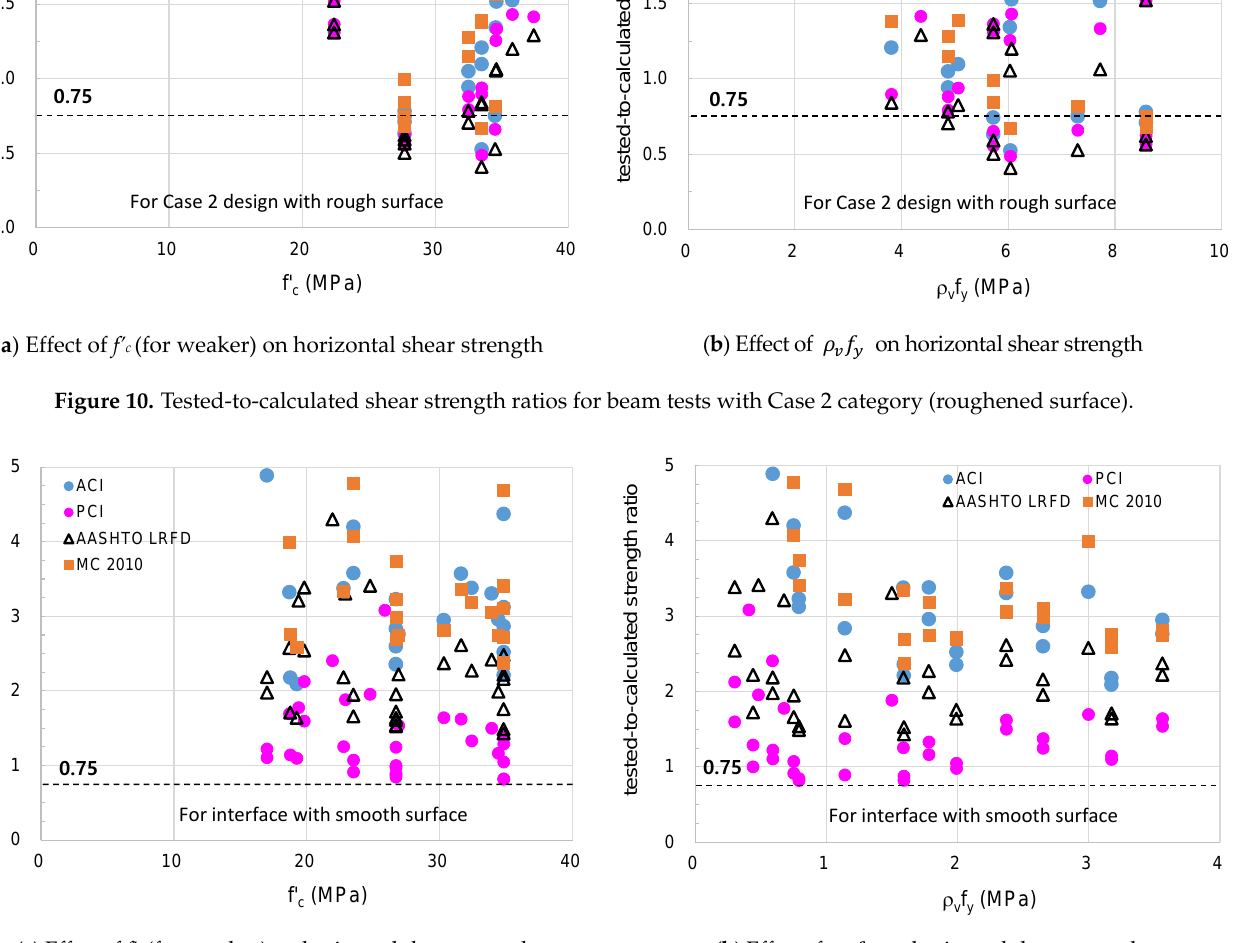
Figure 11. Tested-to-calculated shear strength ratios for beam tests with smooth surface.